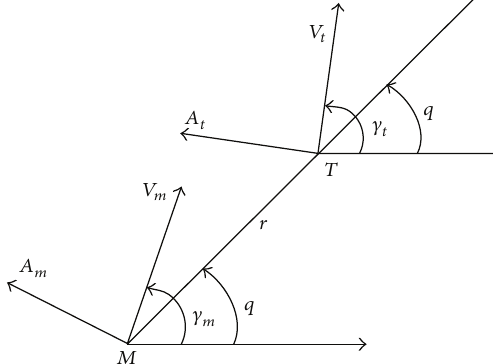
Figure 1: Two-dimensional engagement